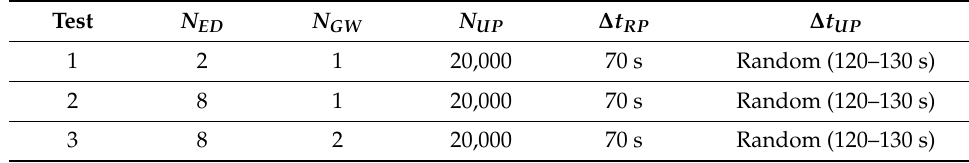
Table 1. Parameter settings for experimental